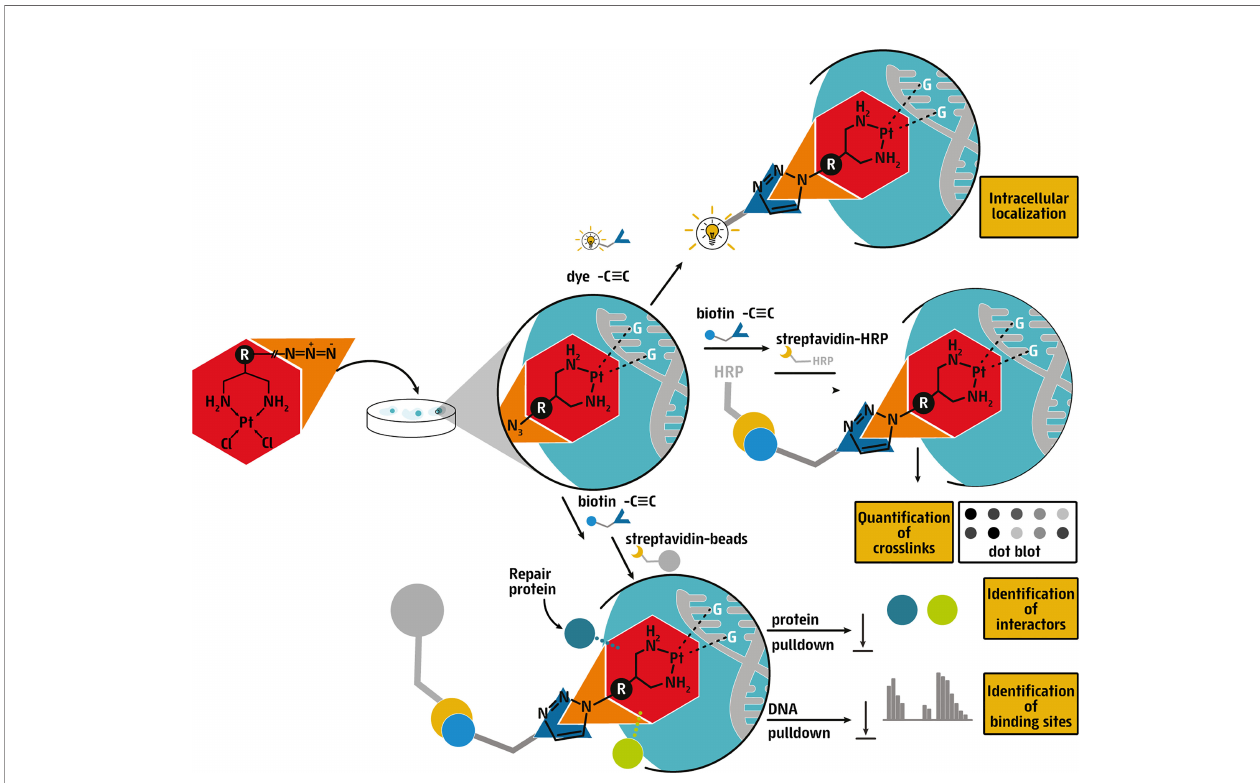
FIGURE 5 | Graphical depiction of the use of clickable cisplatin derivatives to study the DNA damage response. Cisplatin can be modi fi ed with azide or alkyne moieties that are clickable to allow for downstream visualization within nuclei of cells, quanti fi cation of abundance in DNA and interactions with